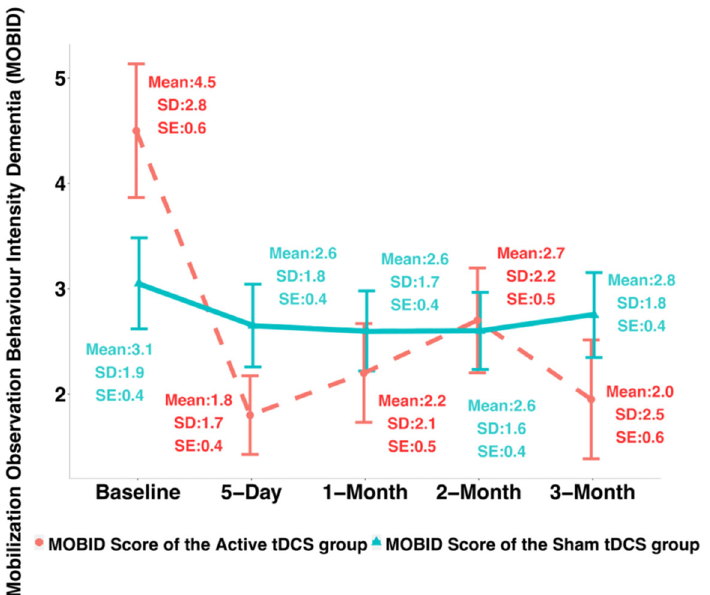
Figure 2. Numerical Rating Scale (NRS) scores over time of the active and the sham tDCS groups ( n = 40). The dashed red line represents the mean NRS scores of the active tDCS group, and the solid green line represents the mean NRS score of the sham tDCS group.